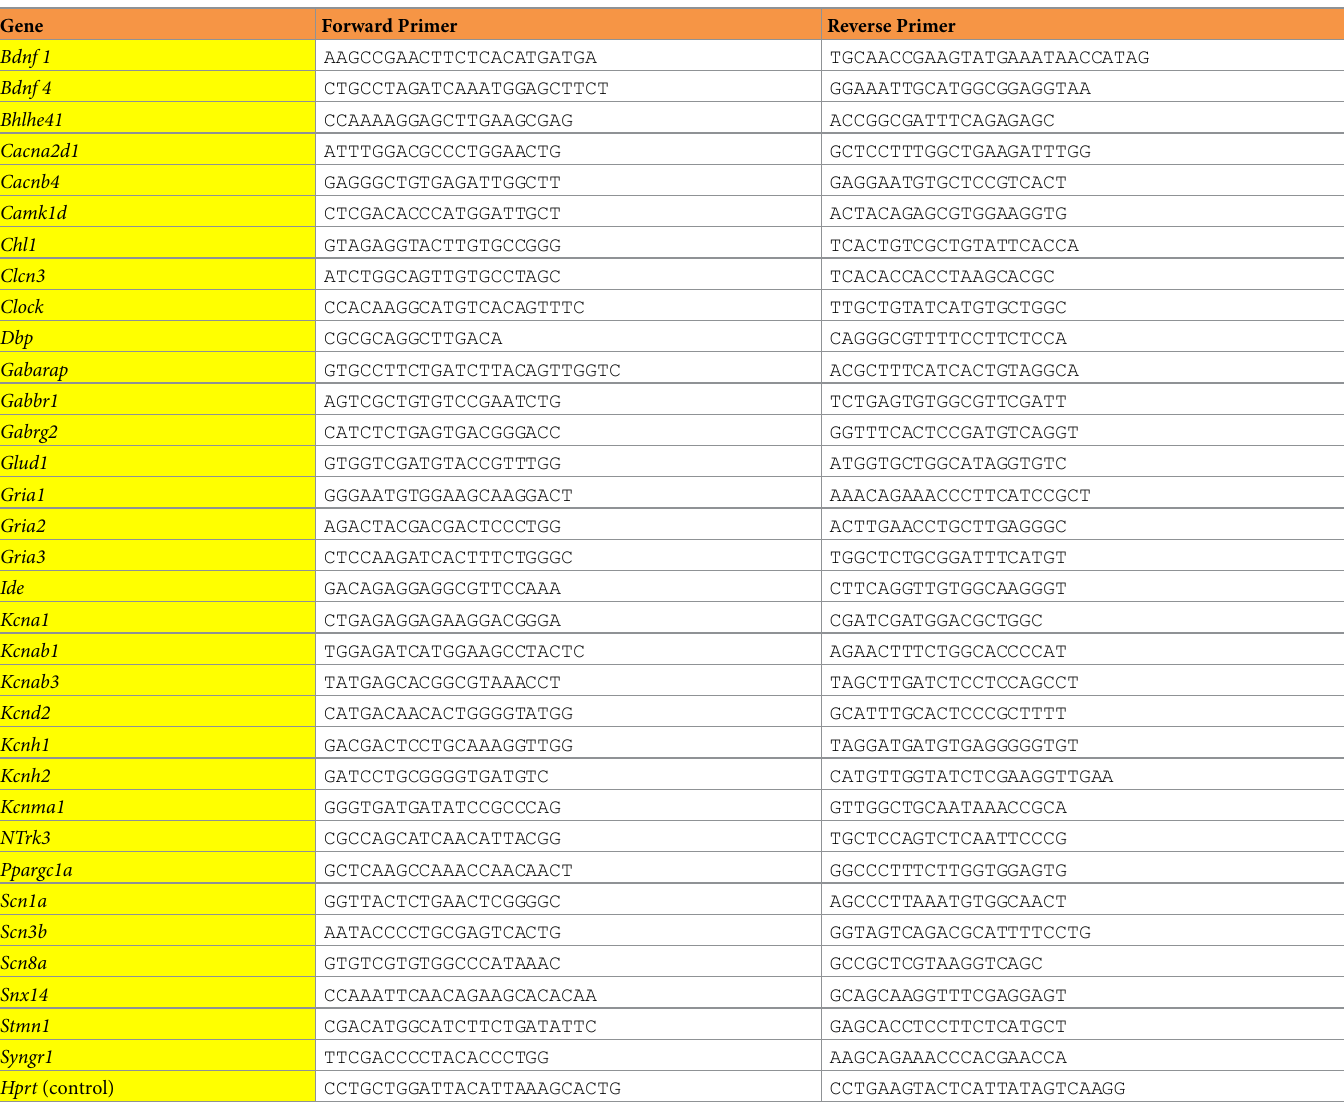
Table 1. Quantitative RT-PCR